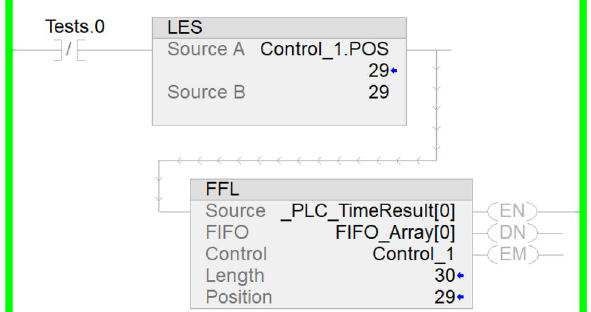
Fig. 16 Using a “FIFO" to capture several values the scan time